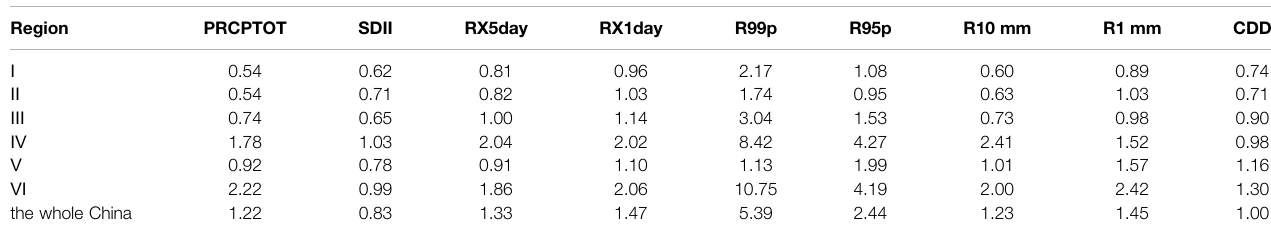
TABLE 5 | DISO for extreme precipitation indices over China. Region PRCPTOT SDII RX5day RX1day Ⅰ